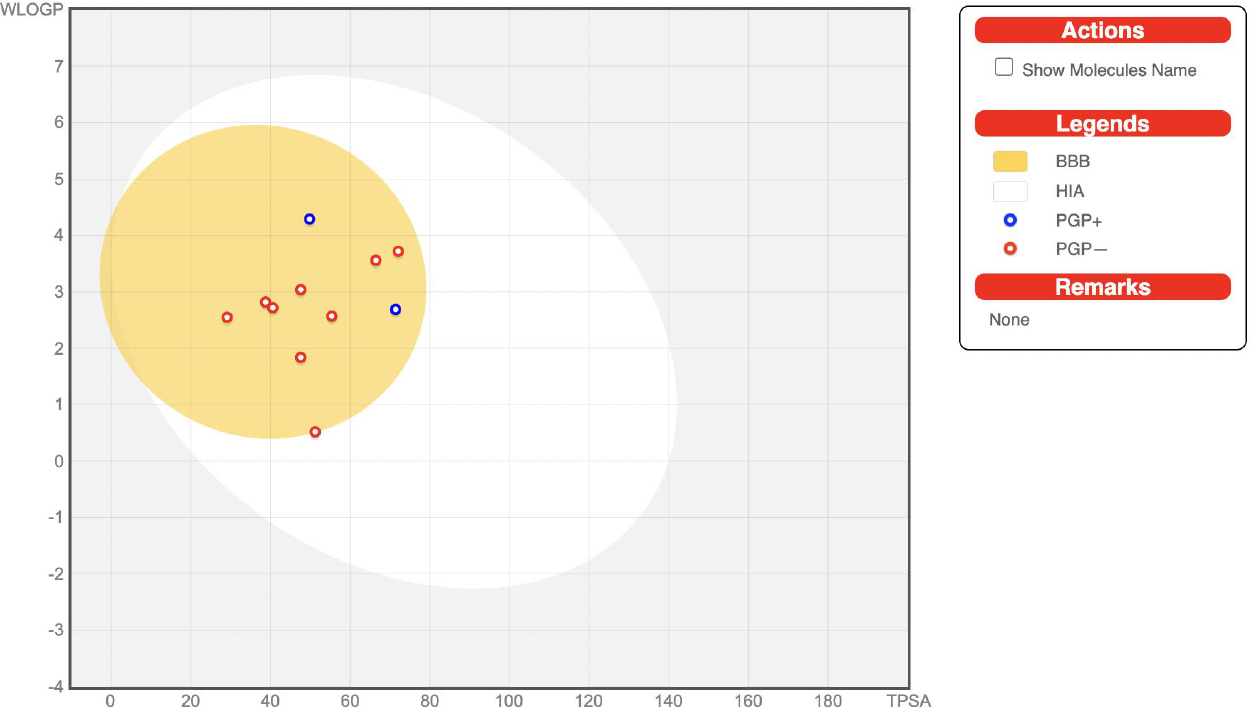
Figure 3. BOILED-Egg plot for compounds 1 − 11